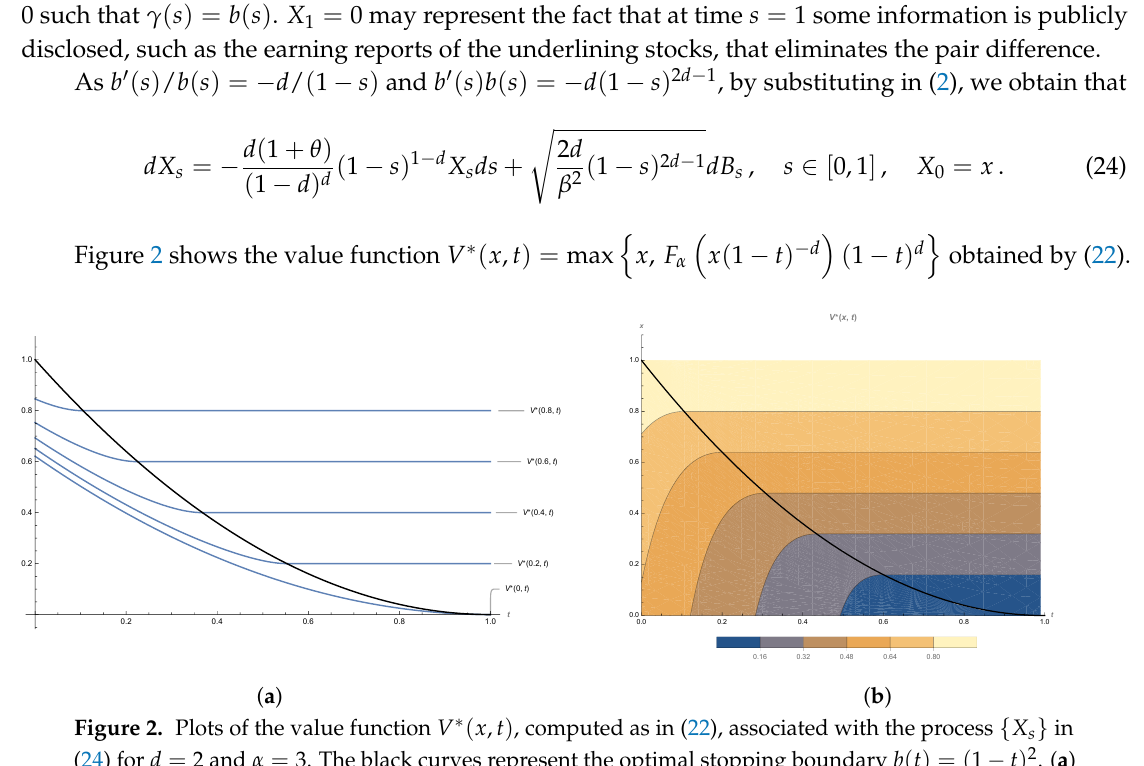
Figure 2. Plots of the value function V ∗ ( x , t ) , computed as in (22), associated with the process { X s } in (24) for d = 2 and α = 3. The black curves represent the optimal stopping boundary b ( t ) = ( 1 − t ) 2 . ( a ) V ∗ ( x , t ) as a funtion of t ∈ [ 0,1 ] for fixed values of x ∈ { 0,0.2,0.4,0.6,0.8 } . ( b ) V ∗ ( x , t ) as a funtion of ( x , t ) ∈ [ 0,1 ] 2